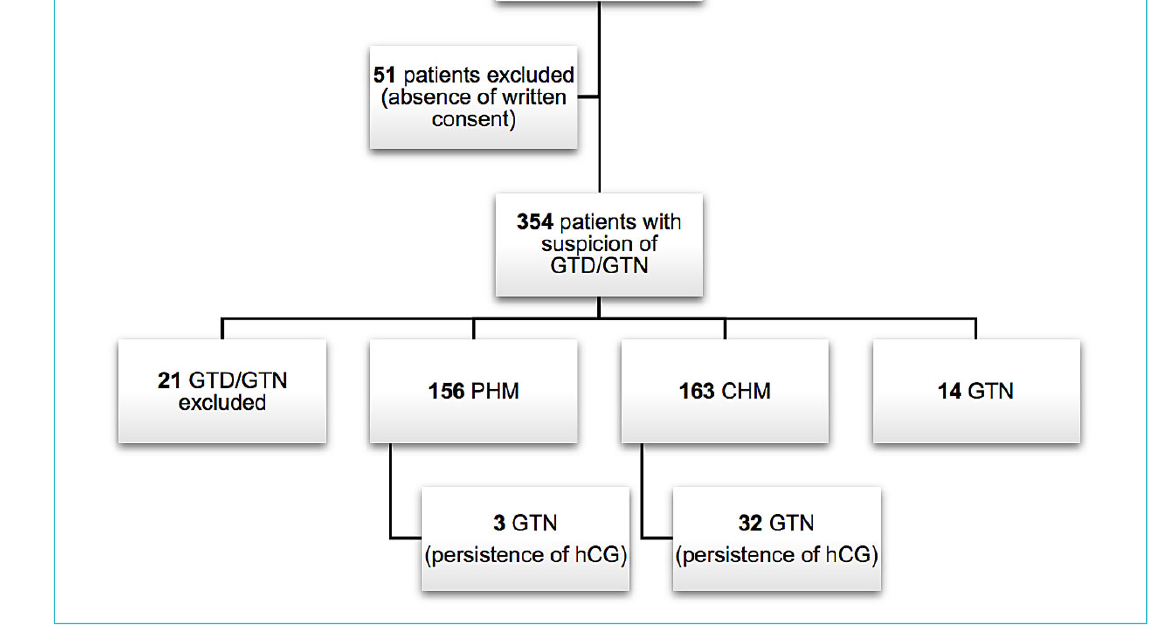
Table 1: Central pathology